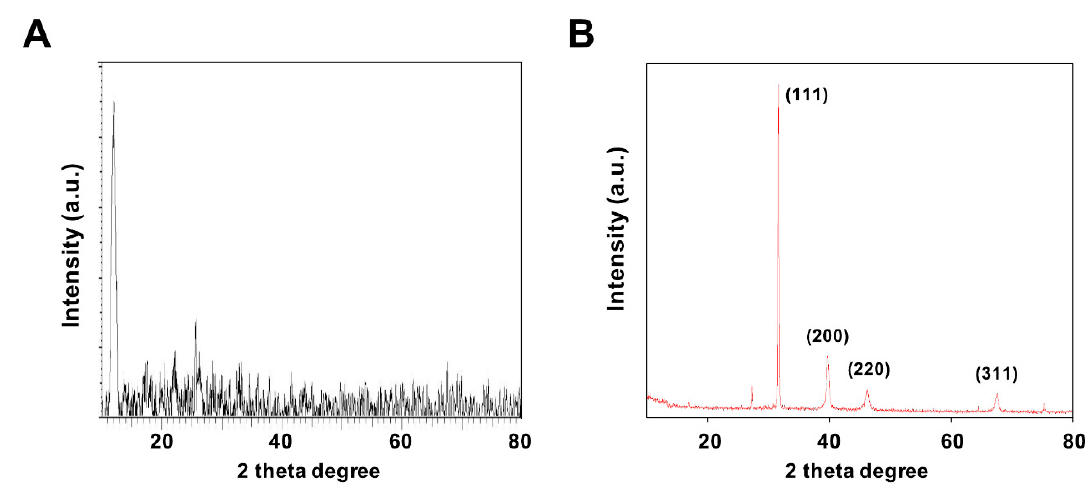
Figure 3. Characterization of GO and GO-PtNPs by XRD. XRD images of GO ( A ) and GO-PtNPs ( B ). At least three independent experiments were performed for each sample and reproducible results were